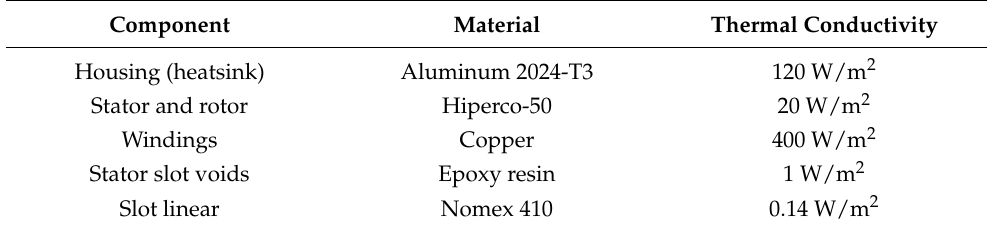
Table 8. Thermal conductivities of materials used in the thermal analysis.